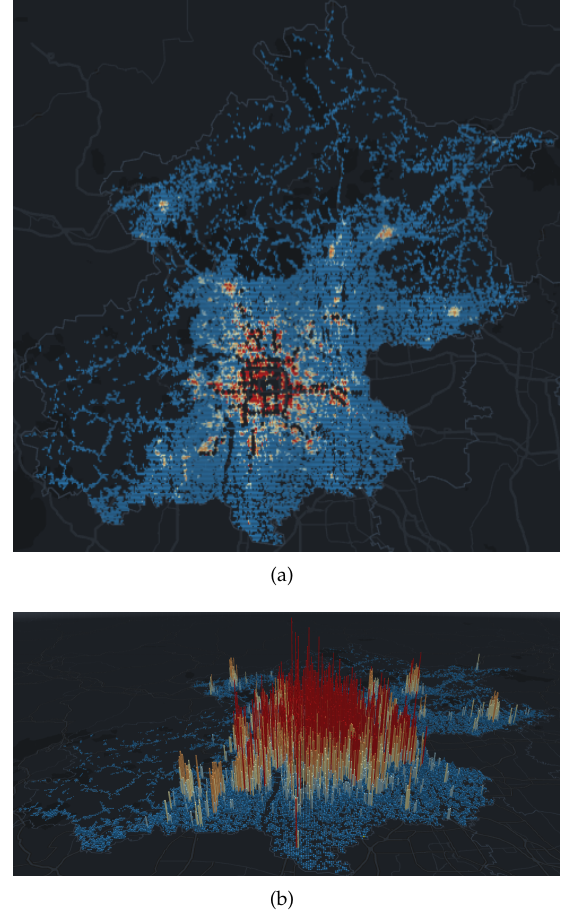
Figure 5. Density visualization of uncovered AP in Beijing. ( a ) 2D density visualization; ( b ) 3D density